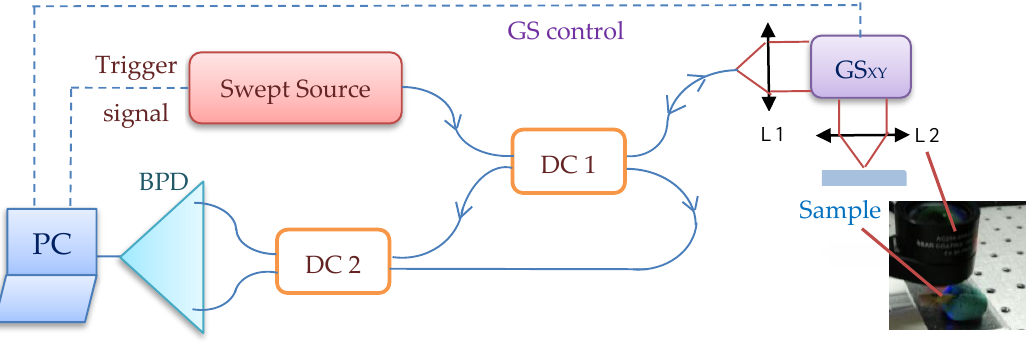
Figure 2. In-house developed MS / SS-OCT system using a single interferometer at two stages. Components: Swept Source; DC 1,2 , single mode directional couplers (20 / 80 and 50 / 50, respectively); GS XY , dual axis galvanometer scanner; L1,2, achromatic lenses; BPD, balanced photo-detector; PC, personal computer.